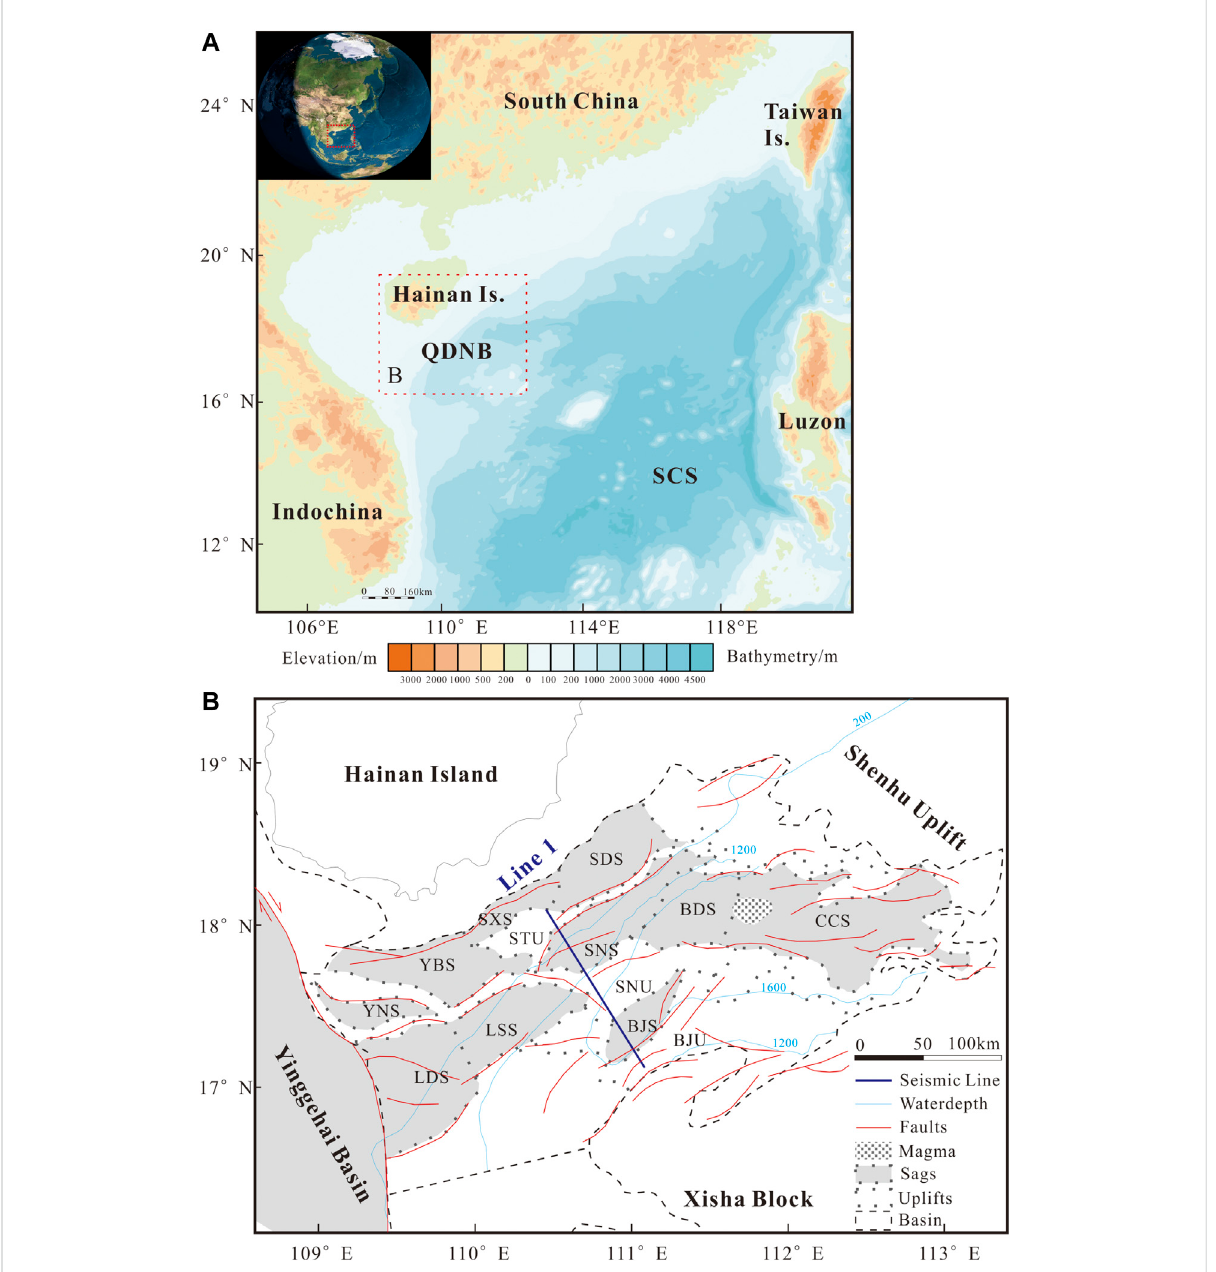
FIGURE 1 (A) Topography and bathymetry ofthe South China Sea (SCS) inthe western Paci fi c. (B) Structural map ofthe Qiongdongnan Basin (QDNB; see locationinFigure1A).Locationofadeep-re fl ectionmultichannelseismicpro fi le(Line1)acrossthecentralpartofQDNBisshown.YNS,YachengNan Sag;YBS,YachengBeiSag;SXS,SongtaoXiSag;SDS,SongtaoDongSag;LDS,LedongSag;LSS,LiushuiSag;SNS,SongtaoNanSag;BDS,BaodaoSag; CCS, Changchang Sag; BJS, Beijiao